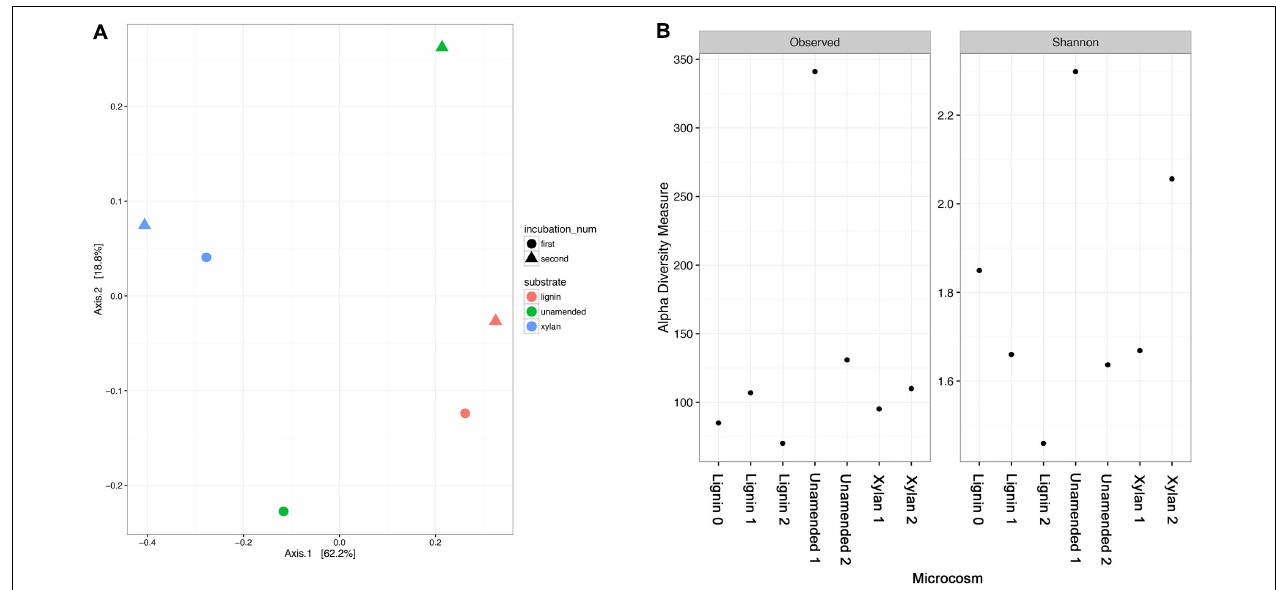
FIGURE 4 | (A) Principal coordinate analysis (PCoA) of the microbial community structures from unamended, xylan, and lignin amended microcosms. The microbial community structures of the microcosms were characterized by 16S rRNA gene amplicon sequencing. Microbial communities were compared using a weighted Unifrac distance before PCoA. The first two axes shown together describe about 80% of the variance between the samples. The incubation is indicated by the color of the point in the ordination plot: pink for the earlier incubation, turquoise from the latter. The amended substrate is indicated by the shape of the point: circle for lignin, square for xylan, and triangle for unamended controls. (B) Alpha diversity of the microbial community structure from xylan and lignin microcosms using number of OTUs and Shannon diversity index. All indices were calculated using the phyloseq package in R.